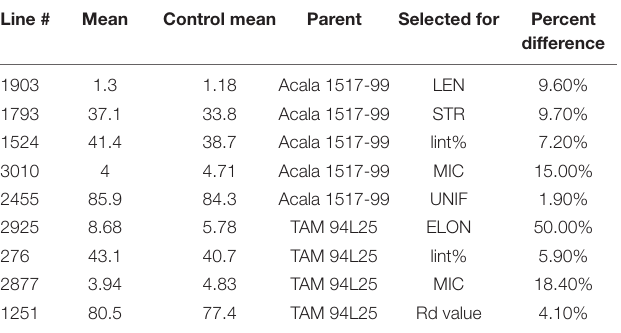
TABLE 1 | Mutant lines from Patel et al. (2014) selected for the breeding scheme.